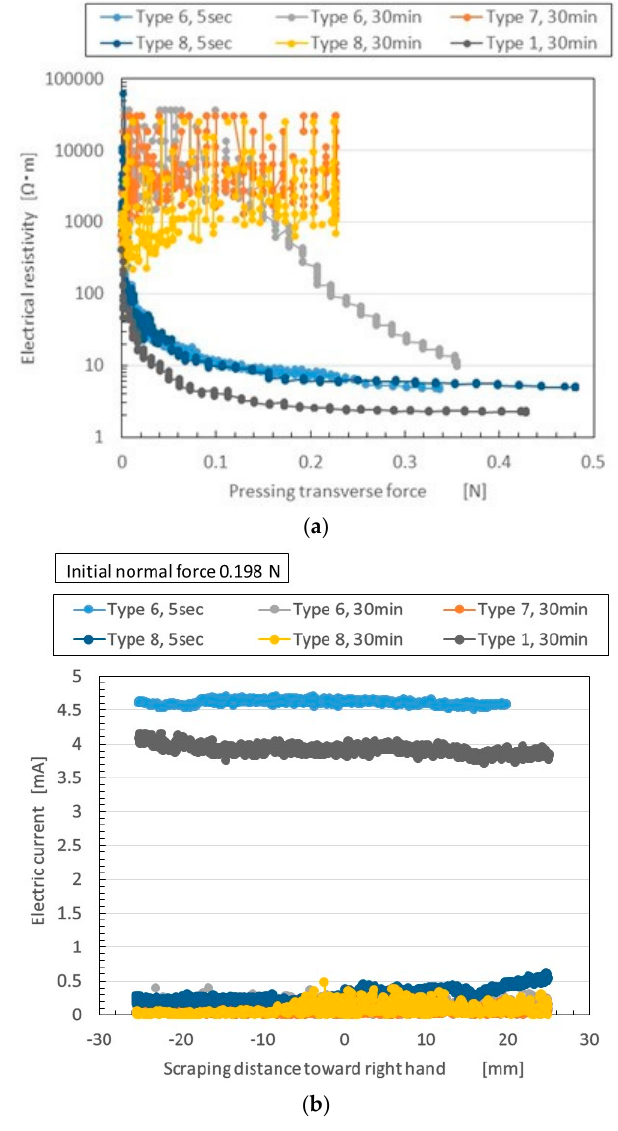
Figure 4. Electric characteristics of MCF rubber with Al 2 O 3 : ( a ) electric property in normal force experiments (NFE); ( b ) that in shear force experiments (SFE).